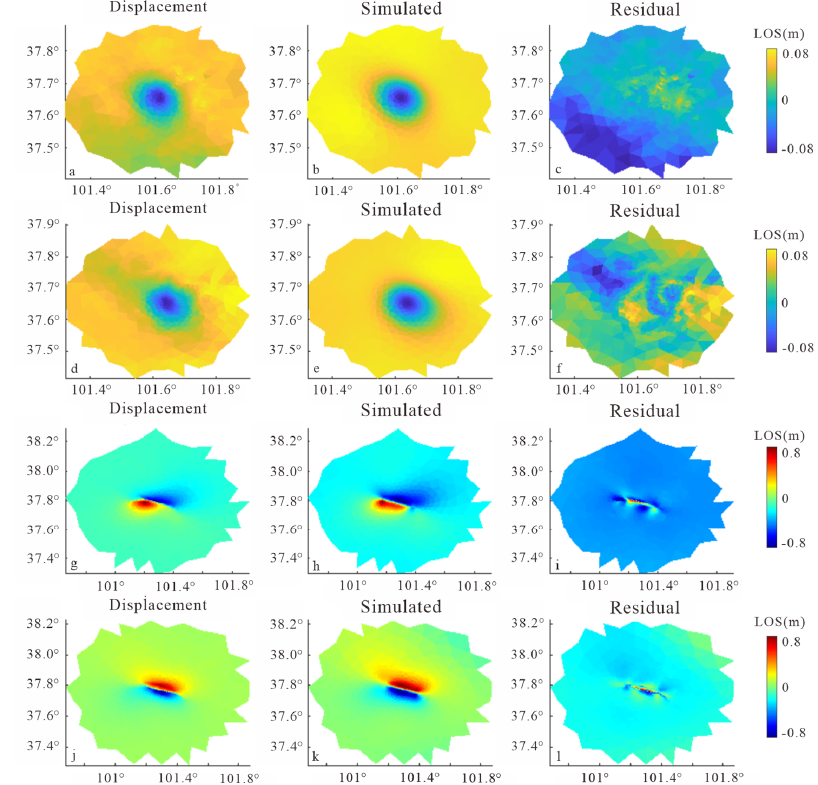
Figure 4. Coseismic deformation fields of the 2016 and 2022 Menyuan earthquakes.